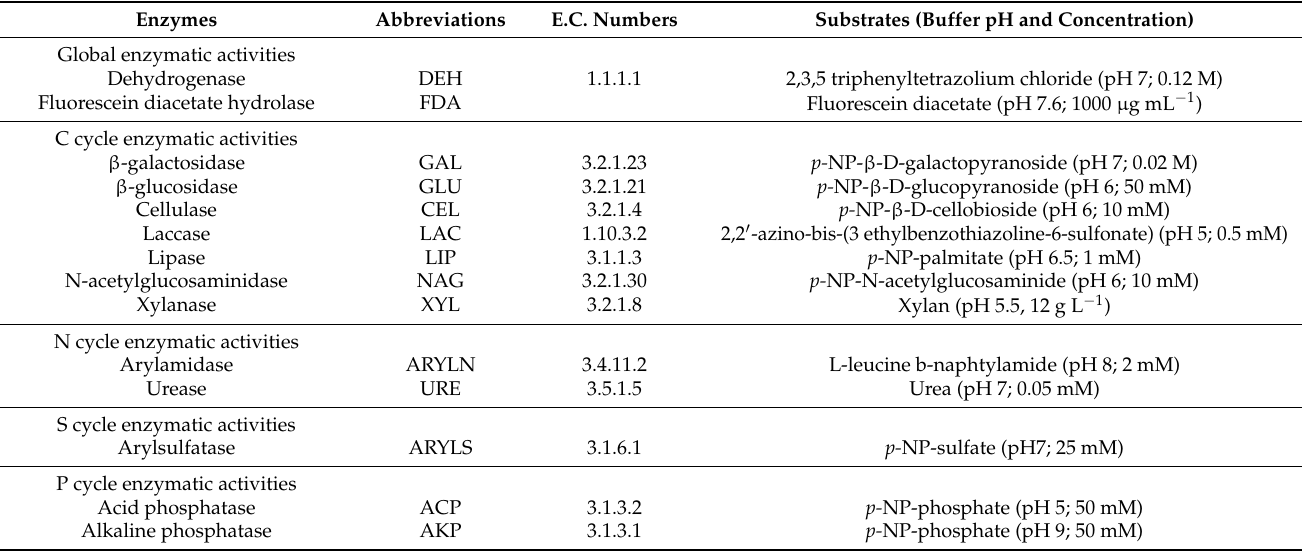
Table 3. Enzymes and substrates used for enzyme activity